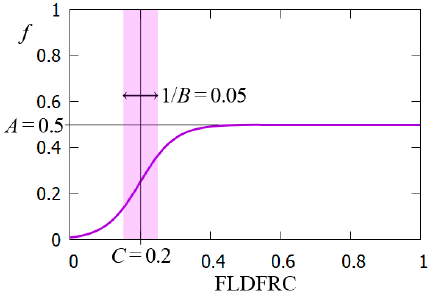
Figure A2. Flood prior probability f versus FLDFRC max .